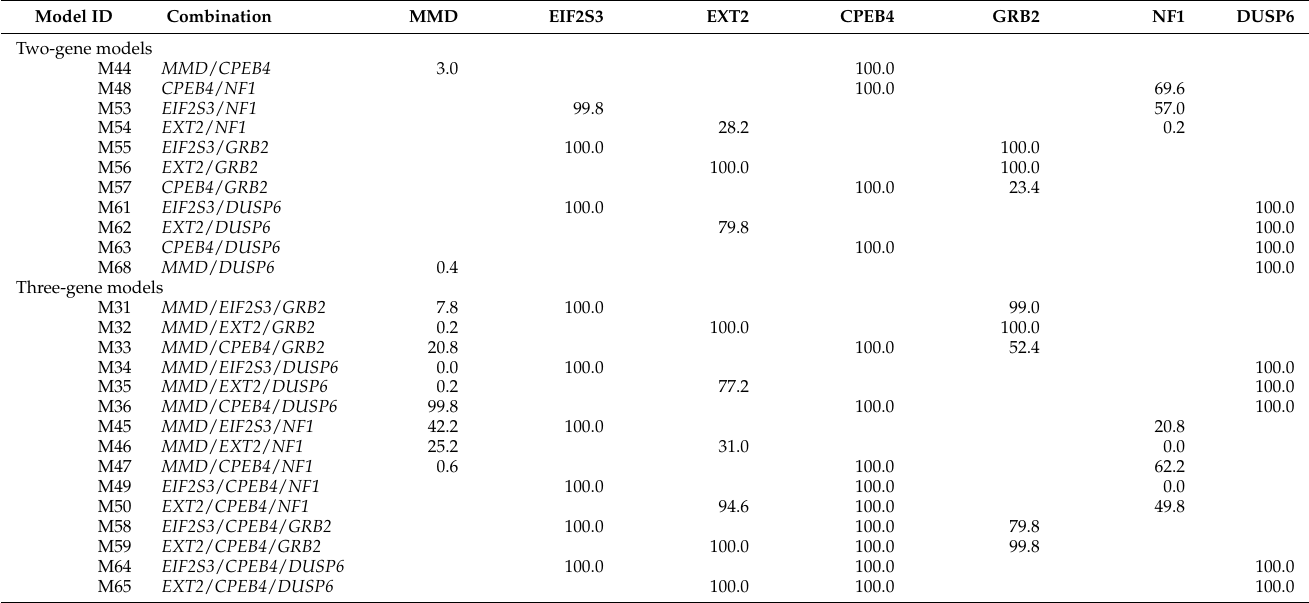
Table 5. Logistic analysis for gene–gene interactions. Percent of significance (PS) of each gene for each two-gene or three-gene model is listed.